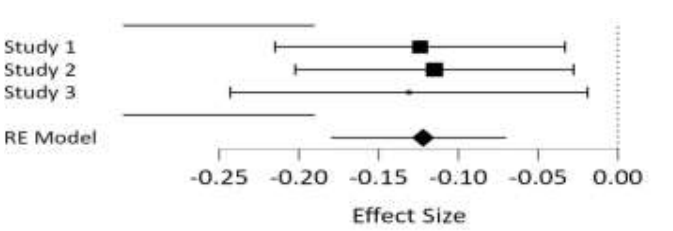
Figure 1. Forest plot of meta-analysis of Amotivation and